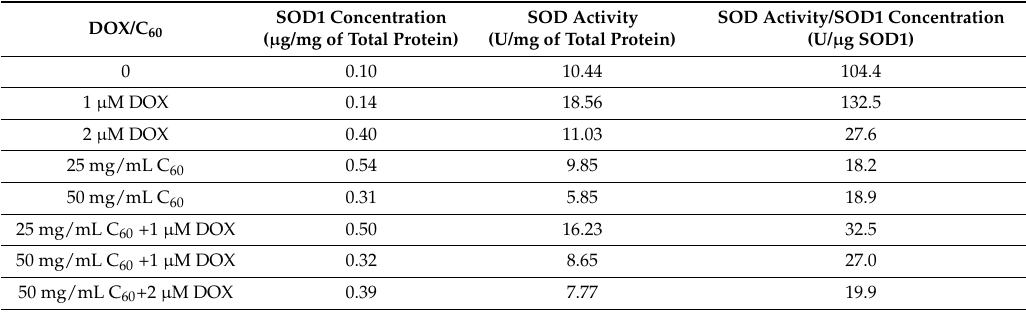
Table 1. Activity of SOD in conversion to SOD1 concentration in MCF-7 cells treated by DOX, C 60 and C 60 –DOX complexes. SOD1 Concentration SOD Activity SOD Activity/SOD1 Concentration DOX/C 60 ( µ g/mg of Total Protein) (U/mg of Total Protein) (U/ µ g